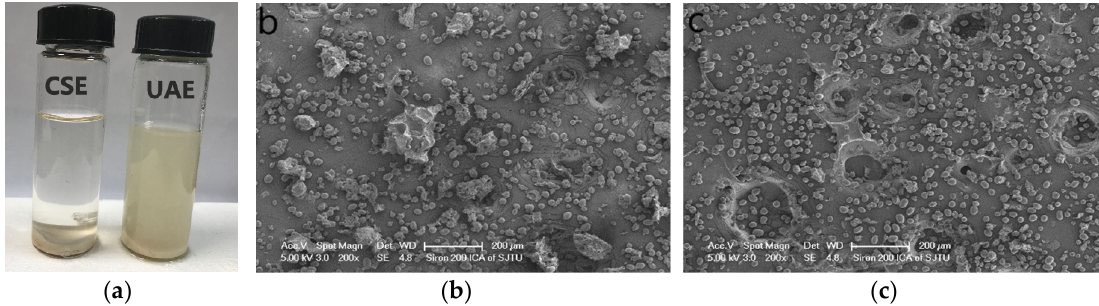
Figure 4. Picture and SEM images of the raw and treated common beans. ( a ) Picture of common beans in solvent before and after treatment; ( b ) raw common bean; ( c ) treated common bean.